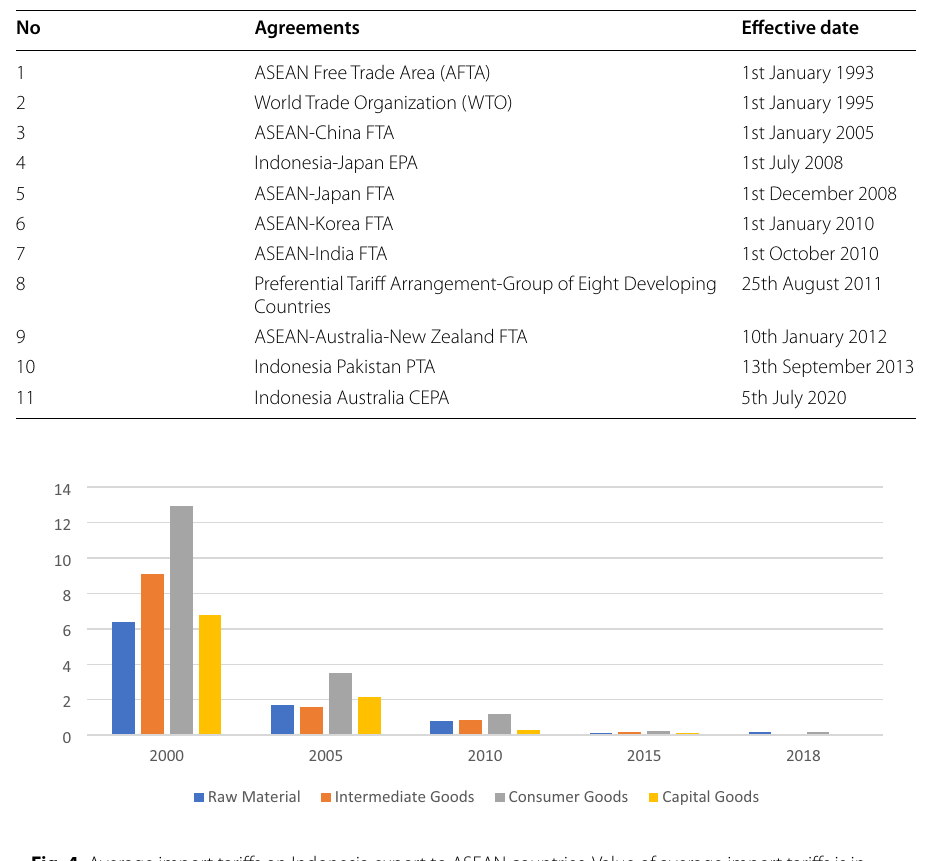
Table 1 Indonesia trade agreement cooperation in effect. Source: Asia Regional Integration Center